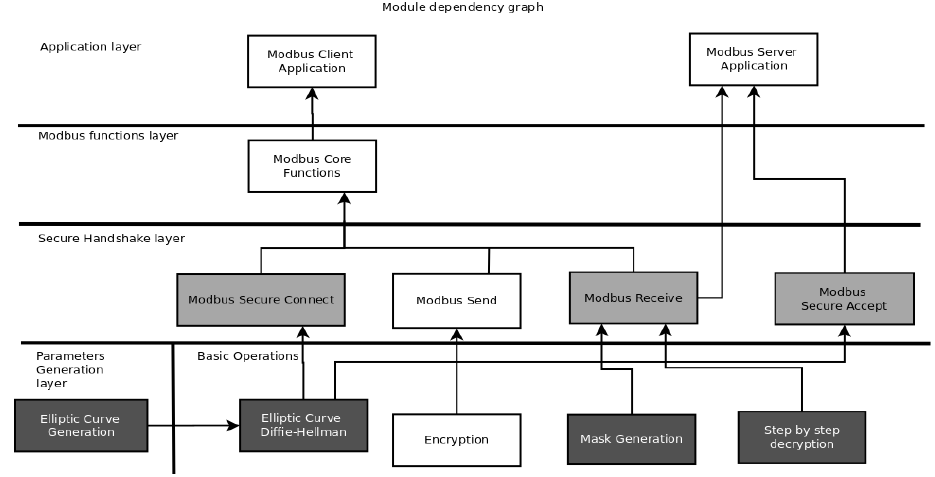
Figure 3. The proposed library and its place within the Modbus